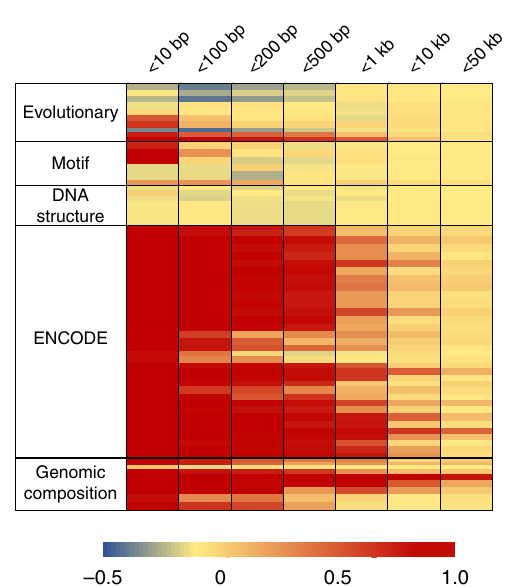
Fig. 4 Correlation of ncSNVs located within speci fi c genomic distances. Given a pathogenic ncSNV, all variants located within 10 bps, 100 bps, 200 bps, 500 bps, 1000 bps, 10,000 bps, and 50,000 bps of its fl anking region were retrieved. For each group, the average correlation coef fi cient was computed for a predictor value and colorized according to the legend bar. A total of 63 predictors were organized into fi ve categories. Evolutionary predictors include 10 scores computed by GERP, PhyloP, and PhastCon.